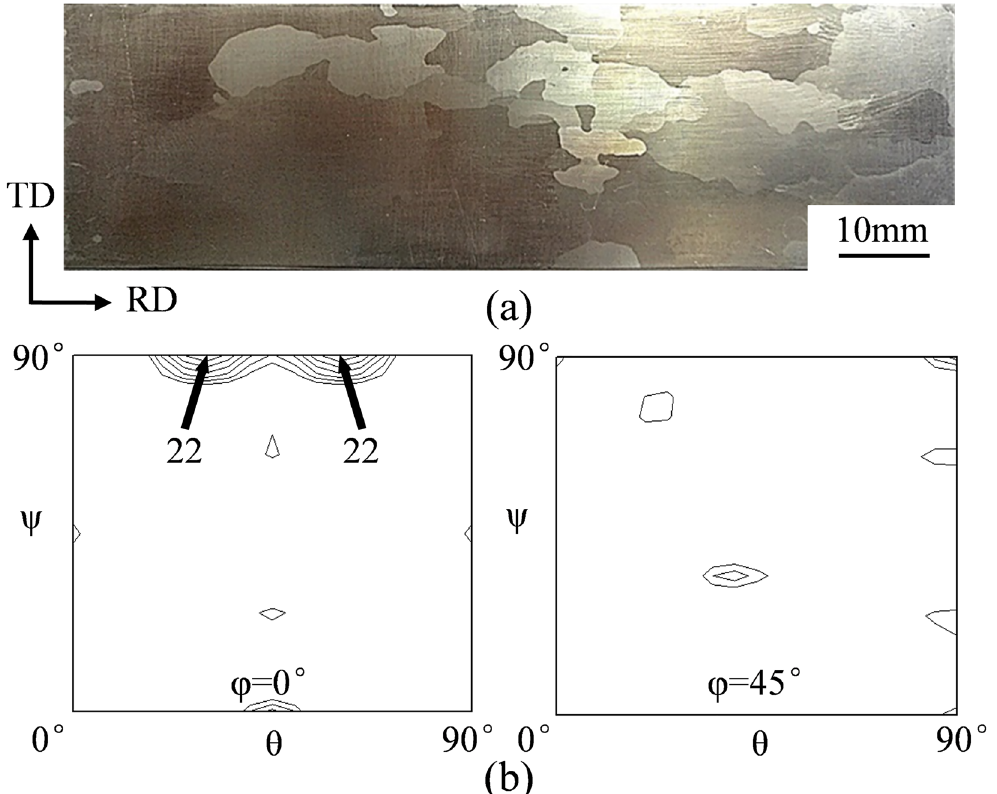
Figure 9. (a) Microstructure and (b) constant φ = 0° and 45° sections of ODFs (levels: 8, 10, 12...) of 89% warm rolled Fe-4.5 wt.% Si sheets after purification annealing at 1200 °C.